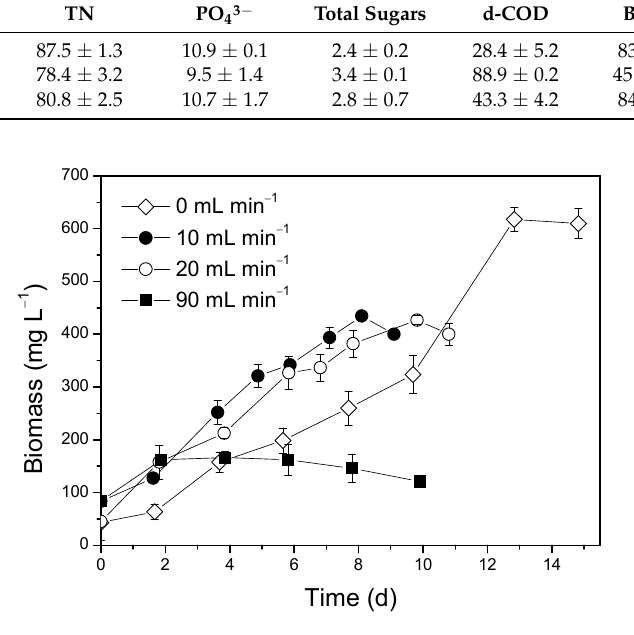
Figure 6. Effect of CO 2 flow rate on the biomass production of T. striata .